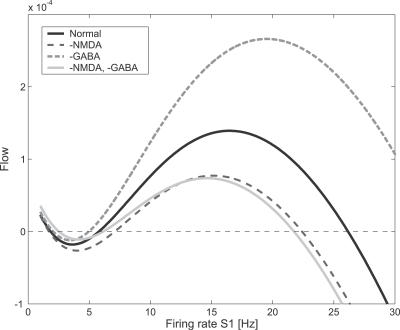
Flow of a Single-Attractor NetworkWe assess the flow of an attractor network with one selective pool using the mean-field analysis for different modifications of synaptic conductances (see Methods section). The flow represents the force which drives the system toward one of the stable attractors. The stable/unstable attractor states are at crossings with the flow = 0 value on the flow axis with a negative/positive derivative, respectively. A modulation of the synapses labelled as (−NMDA) and (−GABA) corresponds to a reduction of 4.5% and 9% of the efficacies, respectively. A pool cohesion of w+ = 1.6 and a selective pool size of 80 neurons were used for the simulations.